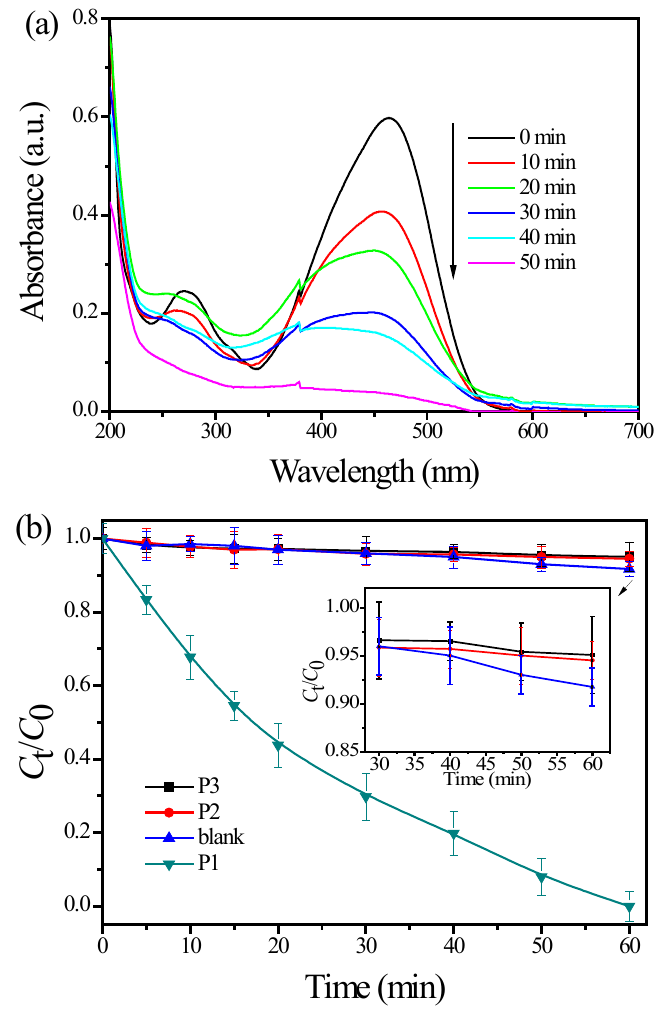
Figure 6. ( a ) Typical UV–vis spectra of MO during the photocatalytic degradation process at the initial concentration 30 µ mol/L in an aqueous pigment P1 (1.0 g/L) and natural pH; ( b ) photodegradation curves of MO over different TiO 2 pigments under UV light irradiation.